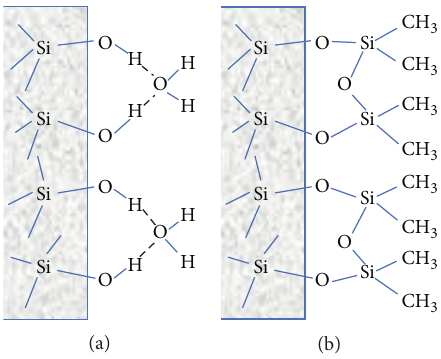
Figure 1: Schematic representation of (a) adsorbed water layer on the surface of hardened cement paste and (b) silicon resin fixed on the surface replacing the water